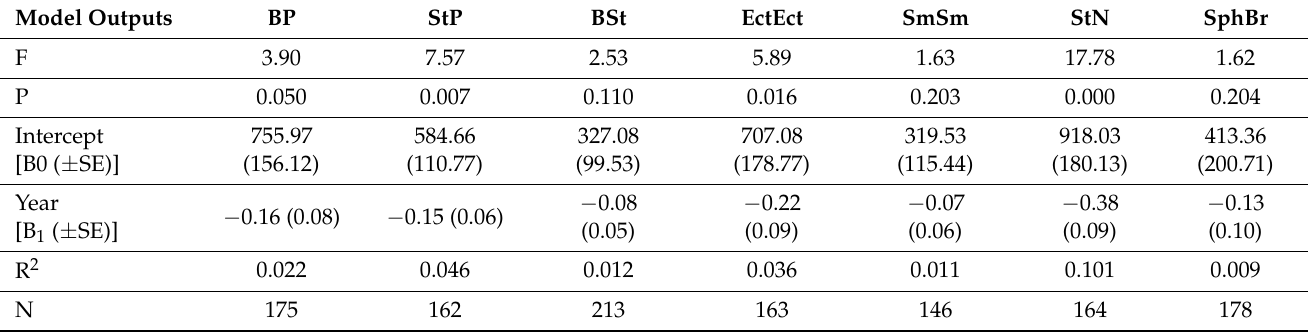
Table 2. Linear regression models of cranial dimensions change over time in